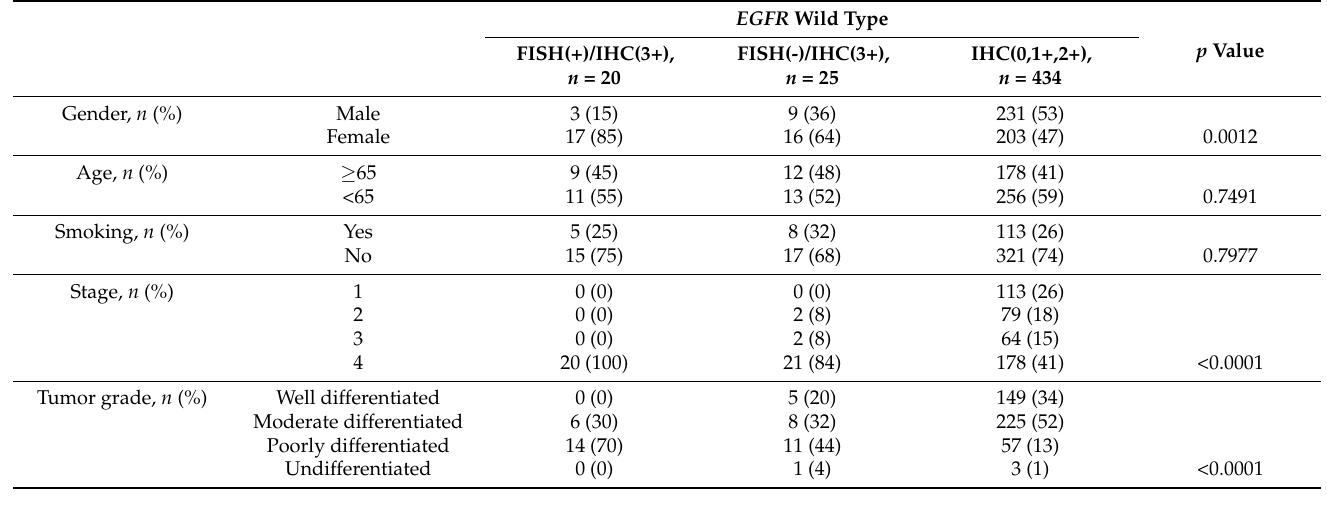
Table 4. Demographics and clinical characteristics in EGFR wild-type prospective cases.